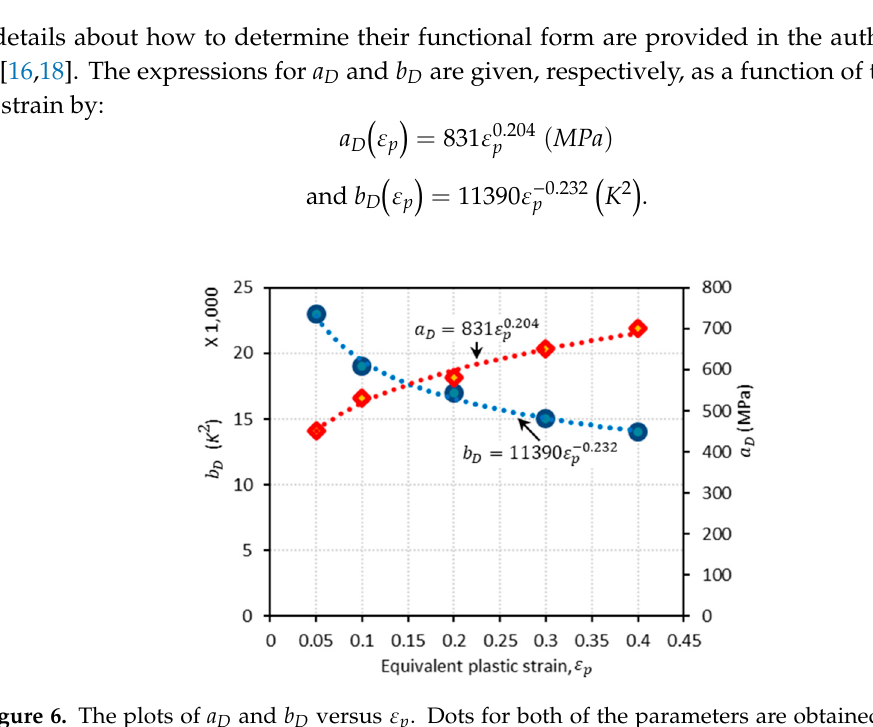
Figure 6. The plots of a D and b D versus ε p . Dots for both of the parameters are obtained from the Figure 6. The plots of (cid:1853) (cid:3005) and (cid:1854) (cid:3005) versus (cid:2013) (cid:3043) . Dots for both of the parameters are obtained from the experimental data [1]. The corresponding trend lines are displayed using a power law form. Figure 6. The plots of (cid:1853) (cid:3005) and (cid:1854) (cid:3005) versus (cid:2013) (cid:3043) . Dots for both of the parameters are obtained from the experimental data [1]. The corresponding trend lines are displayed using a power law form. experimental data [1]. The corresponding trend lines are displayed using a power law form.